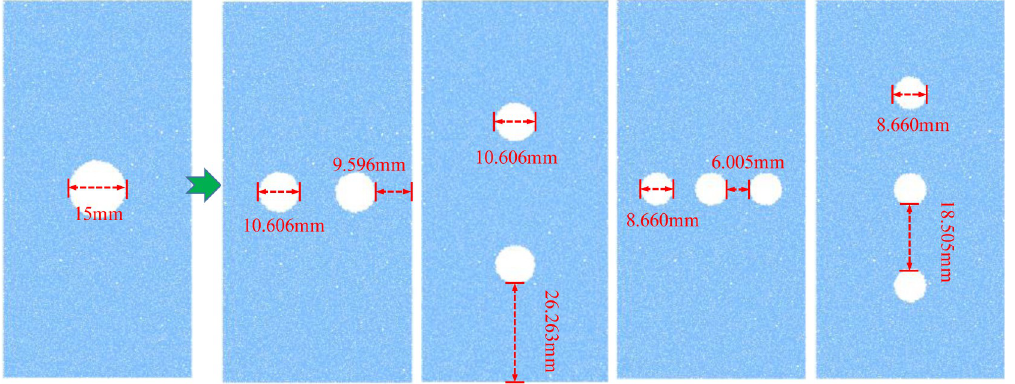
Fig 11. Comparison model of the number and arrangement of circular hole